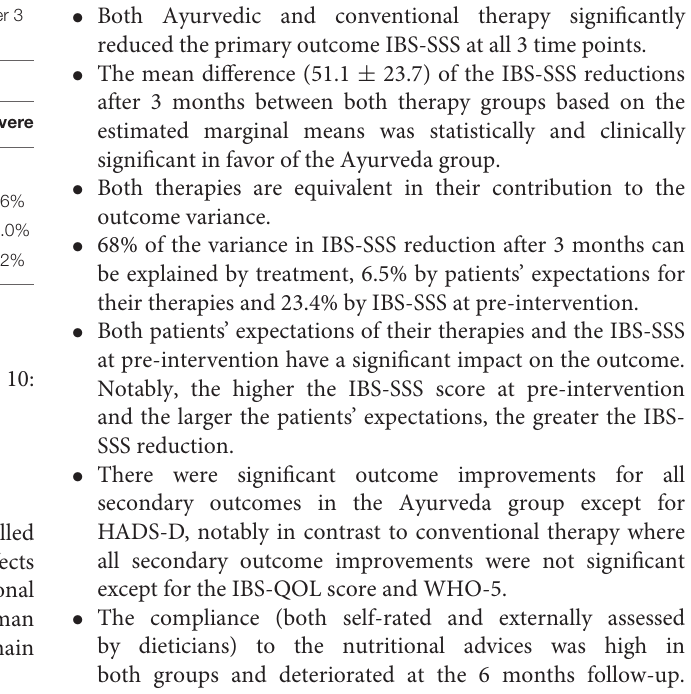
FIGURE 3 | 3D-surface plot of IBS-SSS reduction with respect to IBS-SSS at pre-intervention and patients’ expectations. The higher IBS-SSS at pre-intervention and the larger the patients’ expectations, the greater the IBS-SSS reduction.